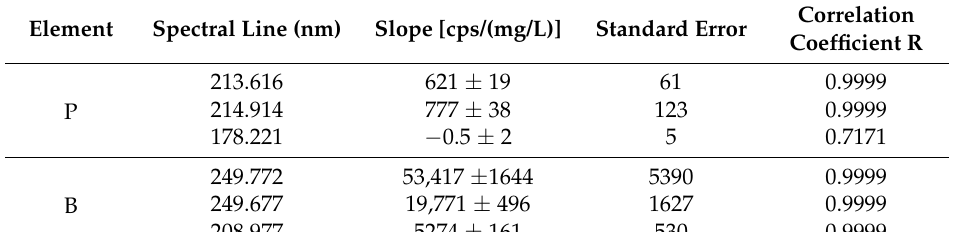
Figure 1. Phosphorus emission spectra at 213.617 nm and 214.914 nm, respectively. Superimposed traces refer to working standard solutions of increasing concentration, as described in the text. Table 5. Results of regression analysis using the mixed standard aqueous solutions of boron and phosphorus.